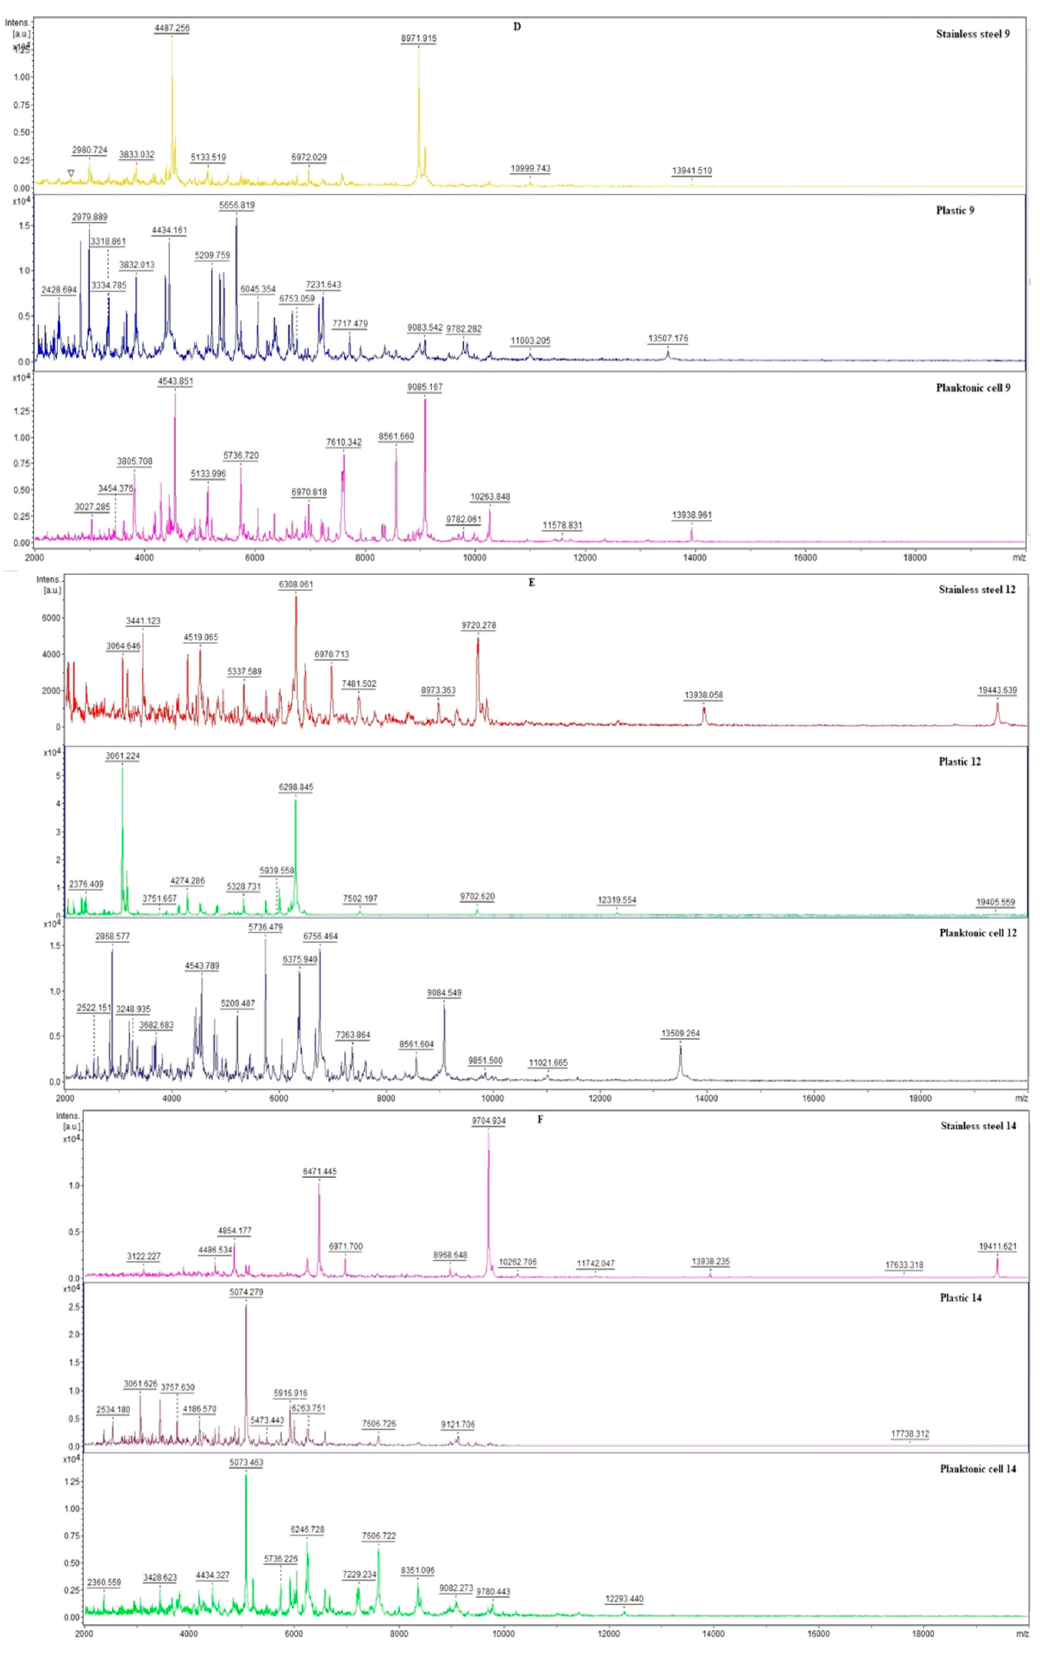
Figure 1. MALDI-TOF mass spectra of P. fluorescens biofilm development after SSEO exposition: